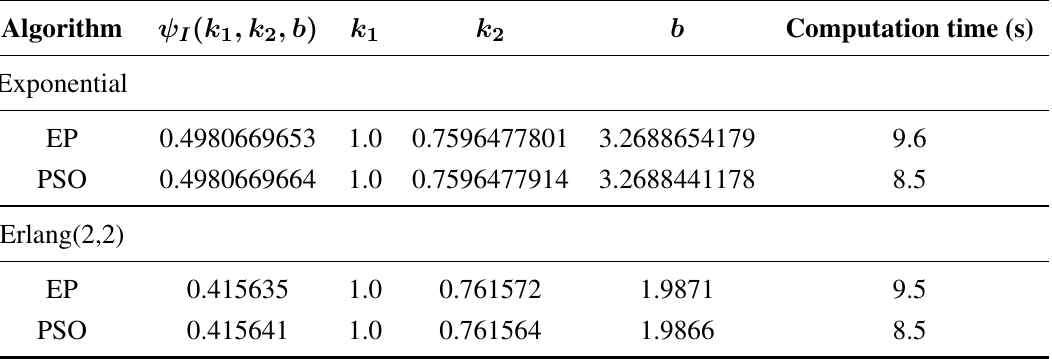
Table 3. Results in Problem 3 (the threshold proportional reinsurance model) using the EP and PSO algorithms.